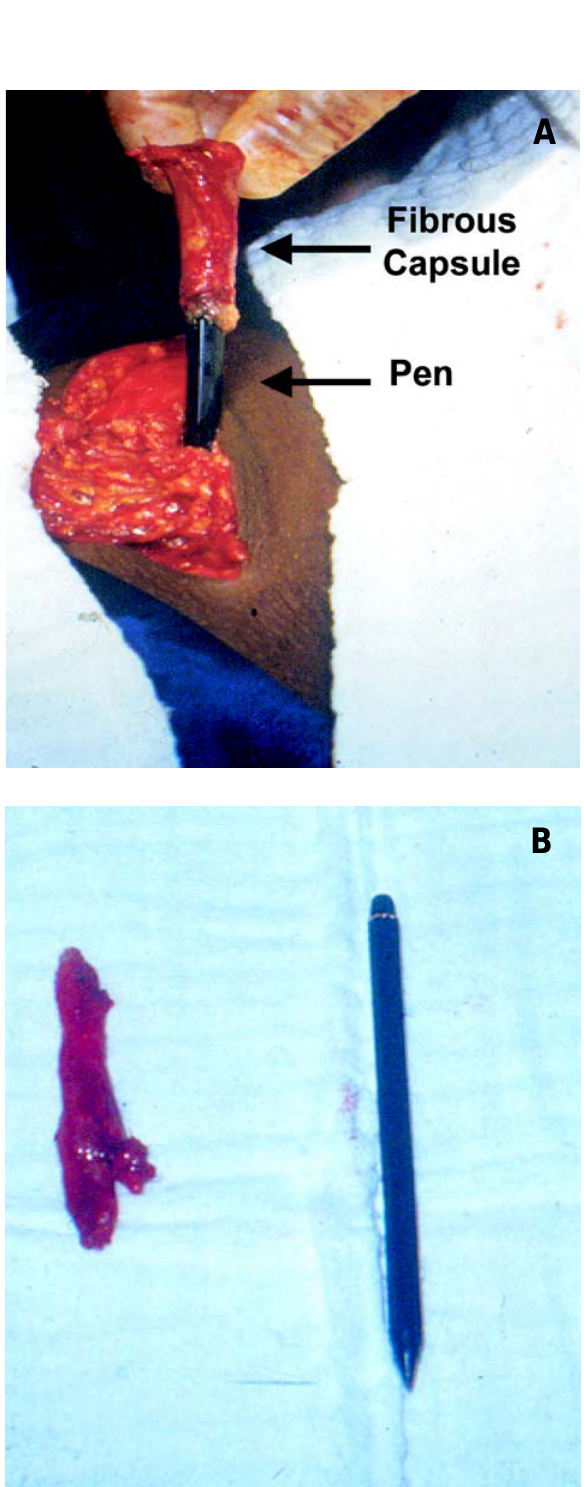
Figure 2 – A) Exteriorization of the pen and fibrous capsule through a left Judd-Gibson incision. B) In detail, the pen and the fibrous capsule